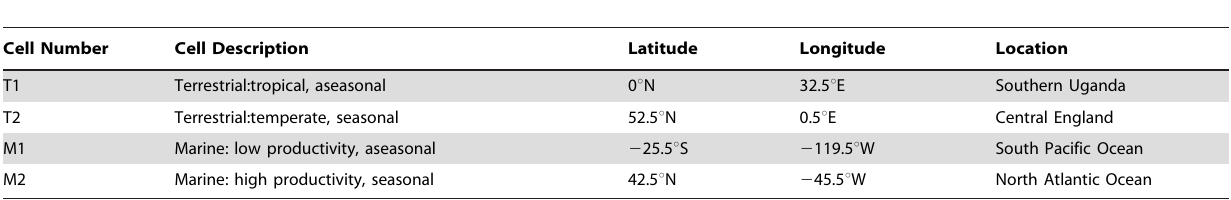
Table 4. Descriptions and coordinates of the focal grid cells for which detailed numerical-, individual-, and community-level model simulations were